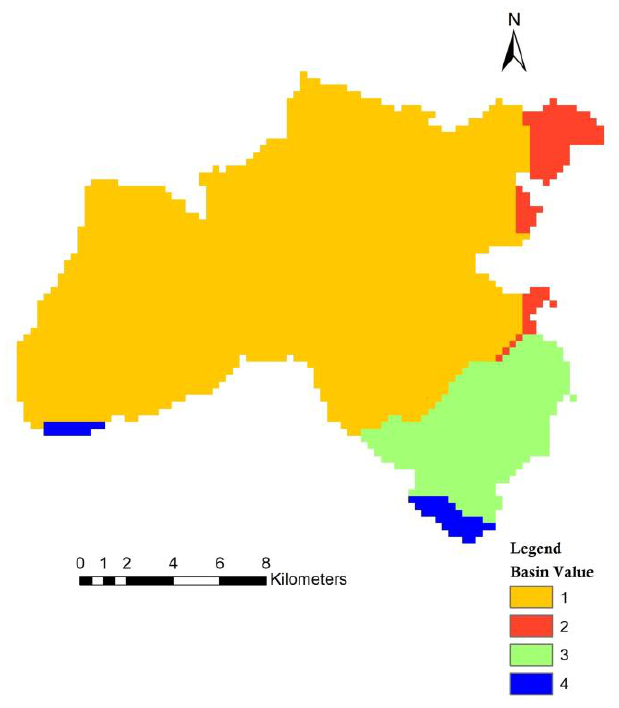
Fig. 4c. Basins in the study